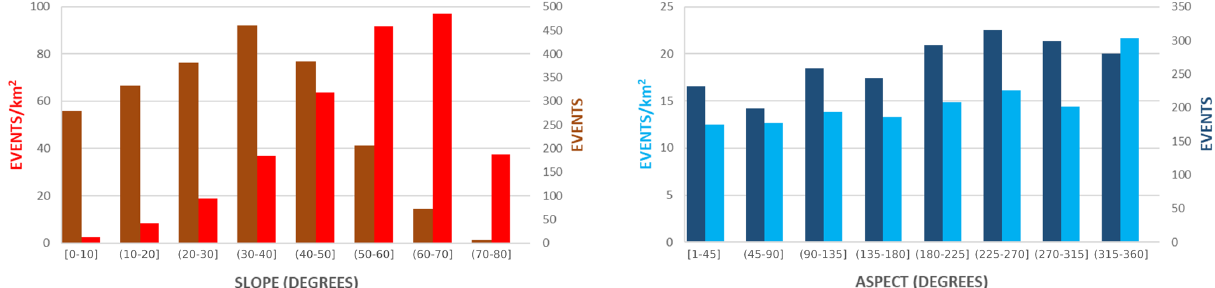
Figure 11. Distribution of the landslide events according to the slope gradient and aspect of the affected hillslopes.